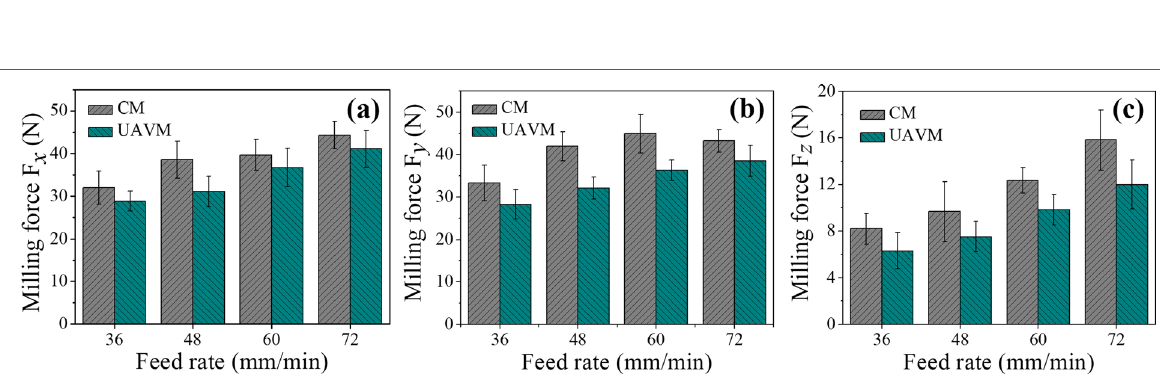
Figure 4 Milling forces against different feed rates ( n